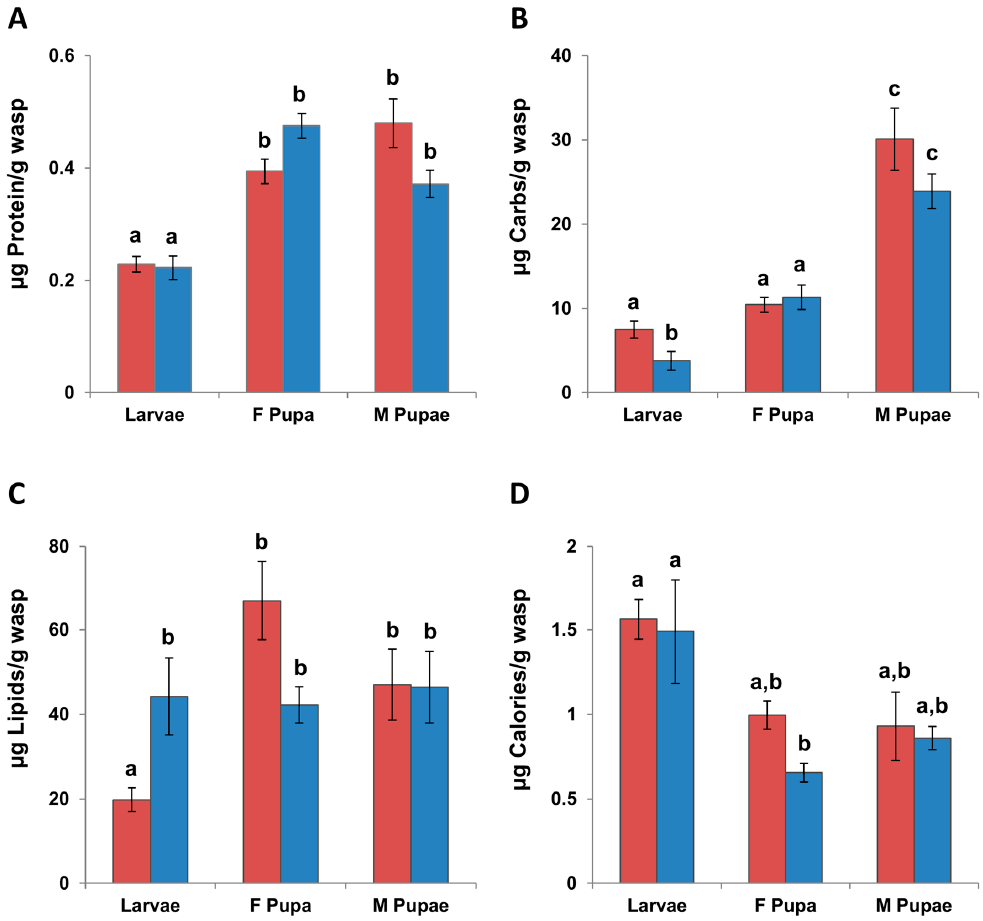
Figure 1. The mean levels of ( A ) protein; ( B ) carbohydrates; ( C ) lipids; and ( D ) calories per unit wet mass in fifth instar larvae (N G1 = 8, N G2 = 7), and male (N G1 = 7, N G2 = 4) and female (N G1 = 8, N G2 = 6) pupae of Trypoxylon lactitarse from the G1 (red) and G2 (blue) generations. Error bars indicate standard error. For each graph, different letters (a–c) indicate significant differences between groups (MANOVA followed by Tukey’s honest significant difference test (THSD)).